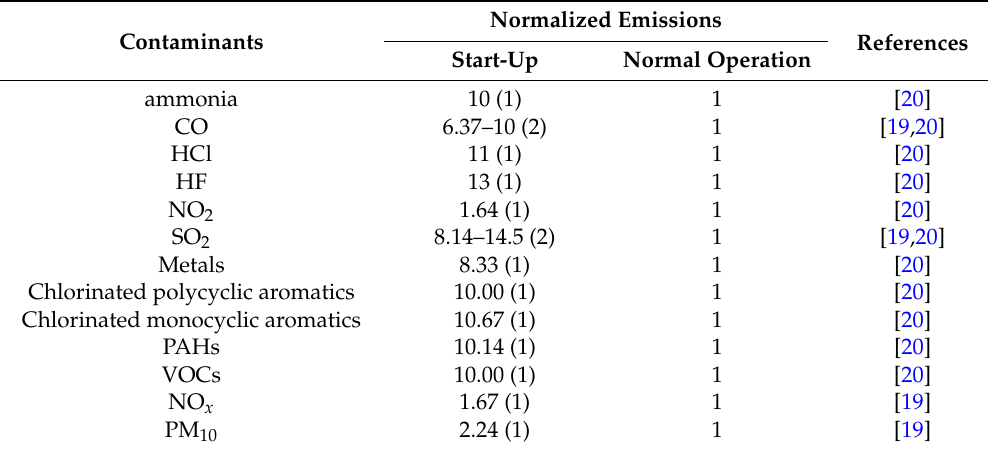
Table 2. Normalized emissions from energy-from-waste generation facilities under start-up and normal operating conditions (number of facilities investigated shown in brackets).